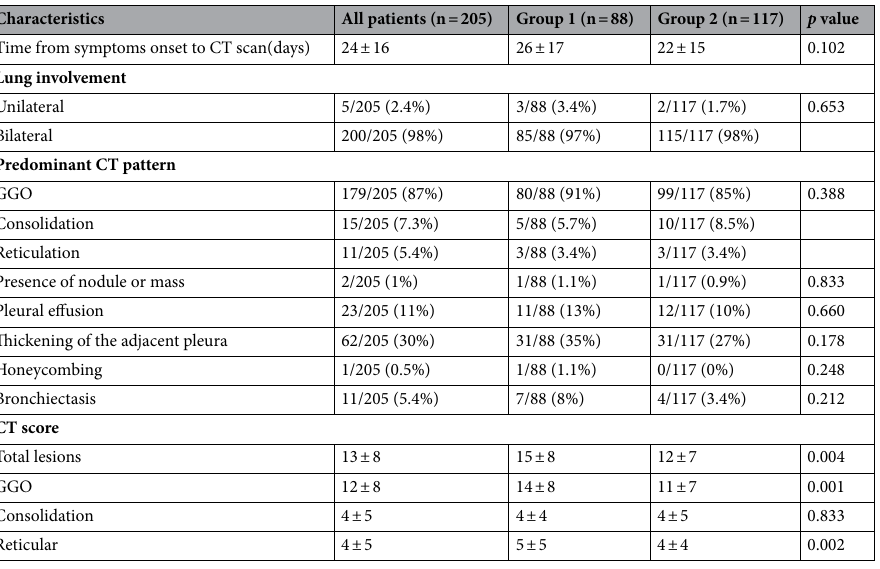
Table 2. Comparison of initial CT findings and scores between groups. The data are presented as medians (interquartile ranges) or n/N (%). p values comparing patients with DLco < 80%(group 1) and patients with DL CO ≥ 80% (group 2) are from χ 2 , Fisher’s exact test, independent-samples T test, or Wilcoxon rank-sum test. GGO ground-glass